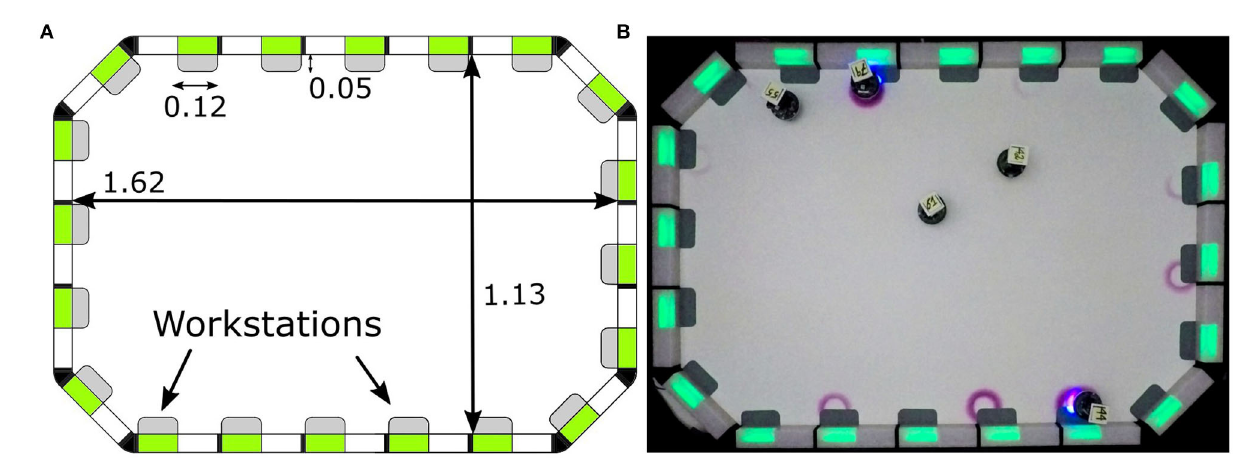
FIGURE 8 | Construction of arena for the TASKING experiments: (A) technical representation of the arena with dimensions and position of workstations, and (B) real arena. Measurements are expressed in